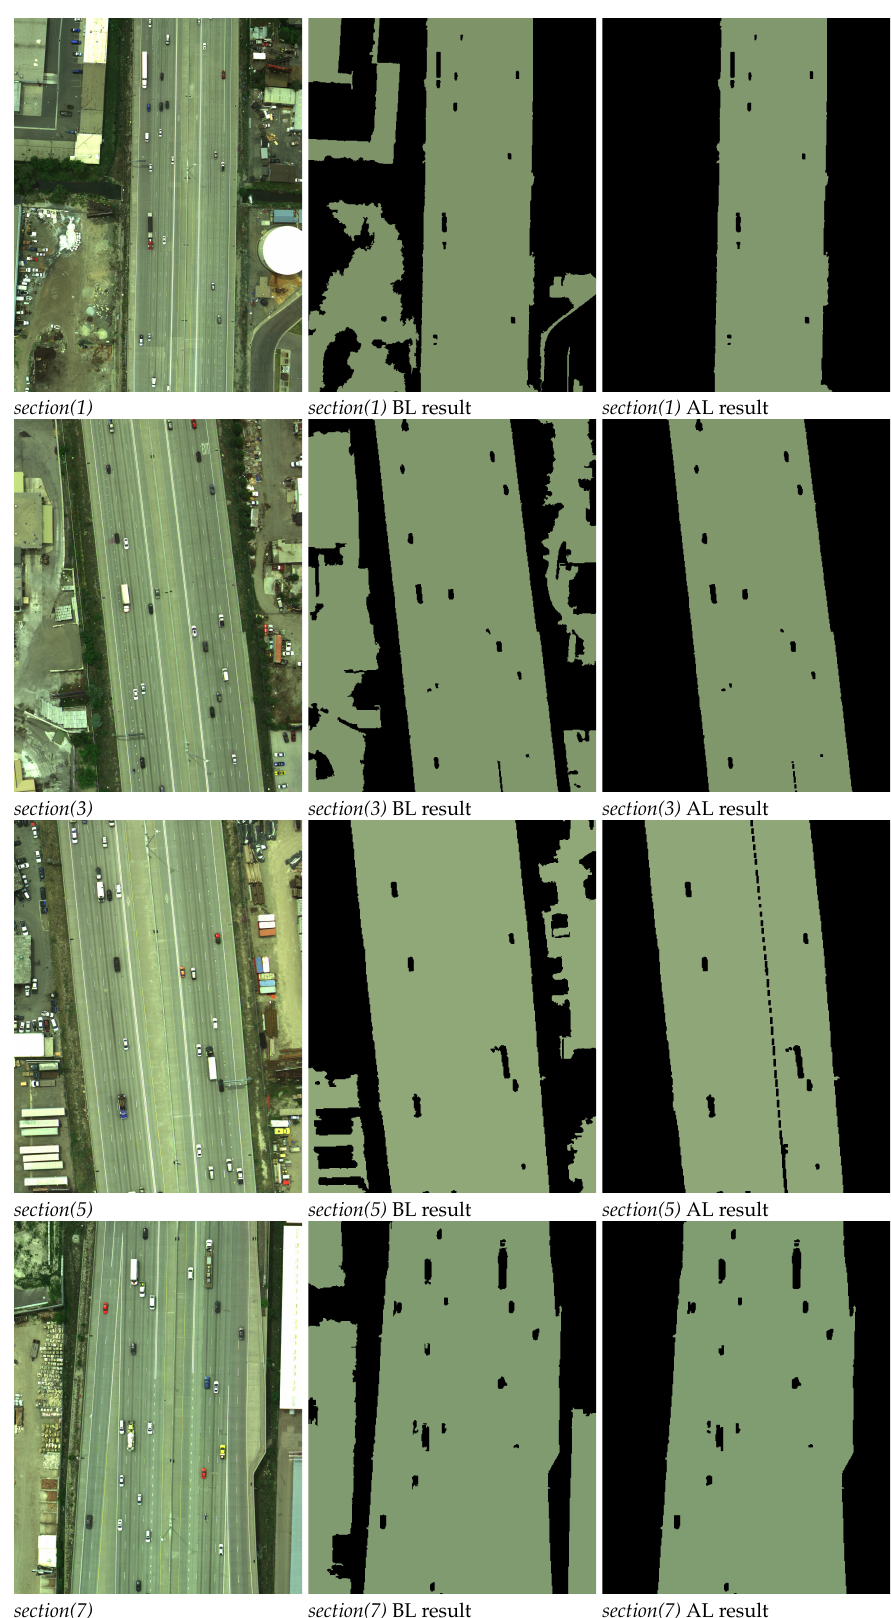
Figure 6. Comparison of road extraction results before and after employing the last learning step for four sections of the road, section(1) , section(3) , section(5) , and section(7)